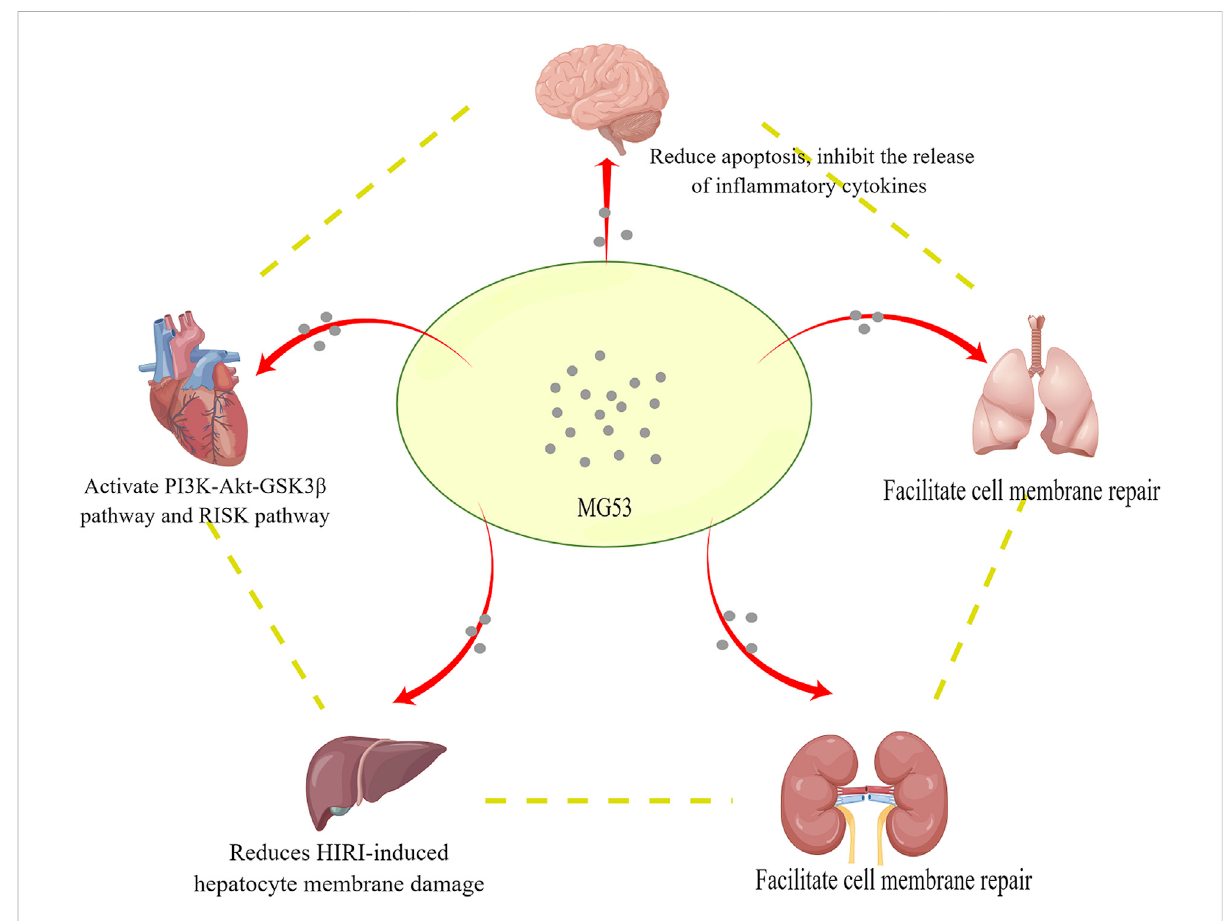
FIGURE 2 MG53 protects multiple organs from ischemia-reperfusion injury through blood